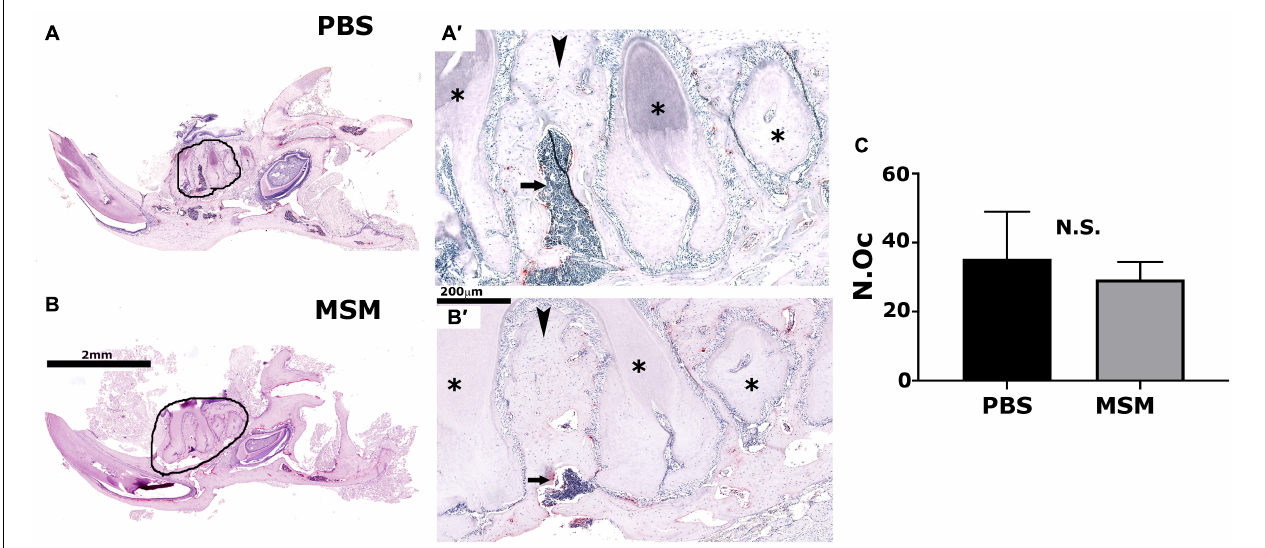
FIGURE 5 | Tartrate-resistant acid phosphatase-stained mandible bone sections in mice injected with PBS (A) and MSM (B) . Representative TRAP-stained mandible sections for each injection are shown. Black circles in panels (A,B) indicate an enlarged view of the bone section in panels (A (cid:48) ,B (cid:48) ) . Arrowheads and arrows point to the inter-radicular bone and the bone marrow cavity, respectively, in PBS- and MSM-injected mice. Asterisks ( ∗ ) denote the dentine of adjacent teeth roots. Scale bars: 2 mm in panels (A,B) and 200 µ m in panels (A (cid:48) ,B (cid:48) ) . Quantification of the number of osteoclasts (N.Oc) (C) was performed in six mice per group using Fiji software (ImageJ). A standard Student’s t -test was used to analyze the data. The number of osteoclasts was not significantly (NS) different between the experimental groups tested.